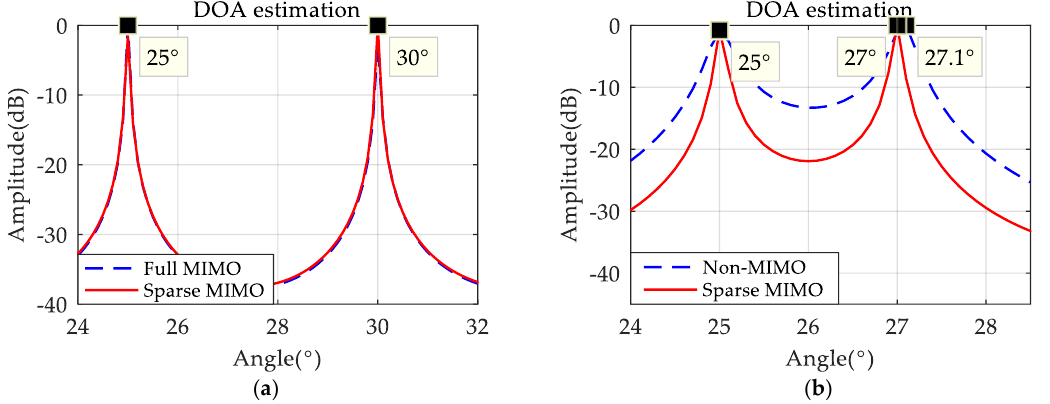
Figure 5. ( a ) direction-of-arrival (DOA) results under the same array aperture; ( b ) DOA results under the same array elements.